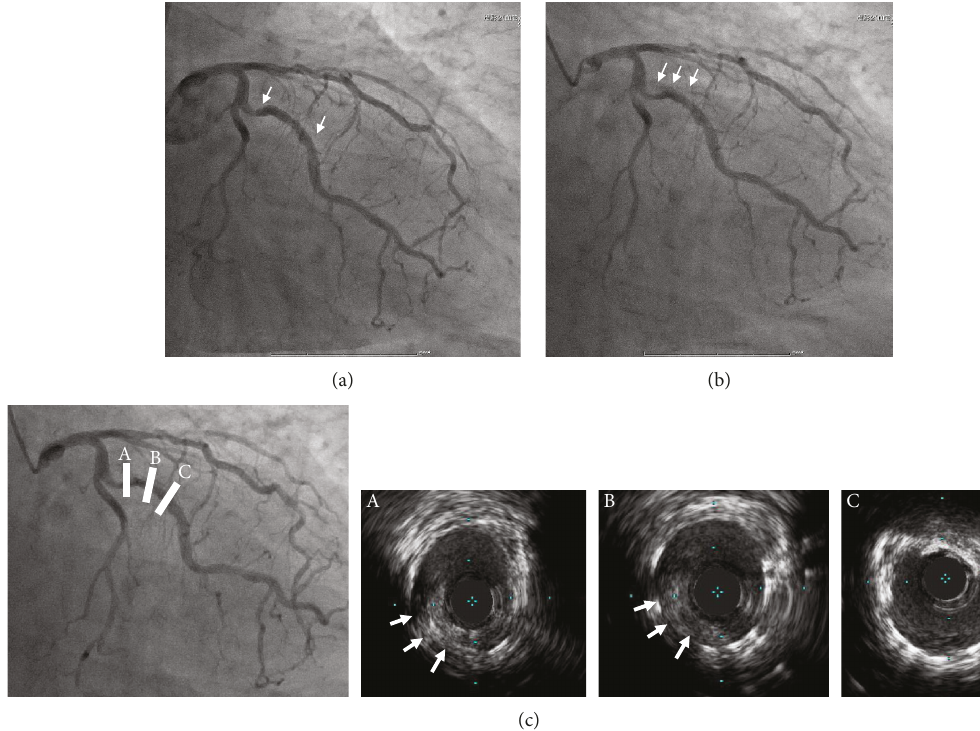
Figure 3: CAG and intravascular ultrasound images during PCI. In the fi rst PCI, a zotarolimus-eluting stent (3.0 × 12 mm) was implanted in #12 (a, between white arrows). Emergent CAG, which was performed 3 hours after the fi rst PCI, revealed massive thrombus in the stent lesion (b, white arrows). The intravascular ultrasound study (c) showed the new lining thrombus (white arrows) in the stent proximal (A and B), whereas not in the distal